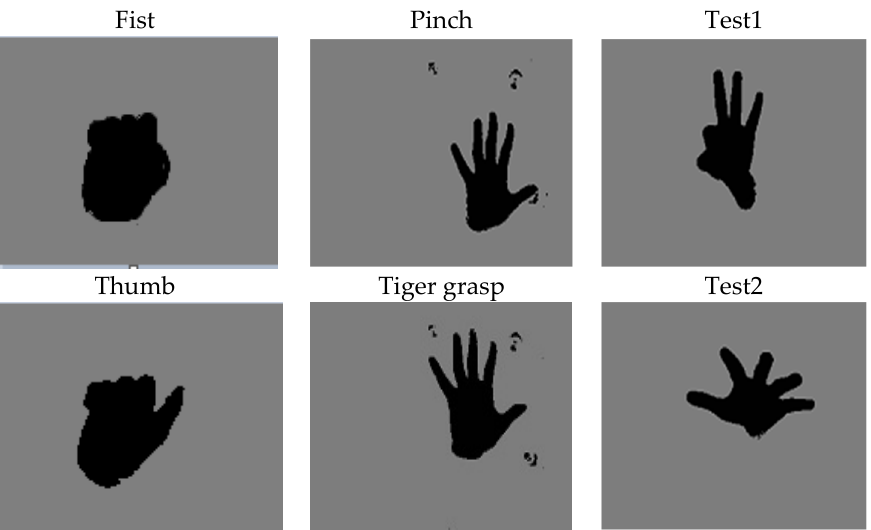
Figure 1. A few hand posture samples from selected hand posture datasets, ( left ) Kaggle Samples [33], ( middle ) Dexter Samples [22], ( right ) First Person Samples [34]. Table 1. Details of hand posture datasets.